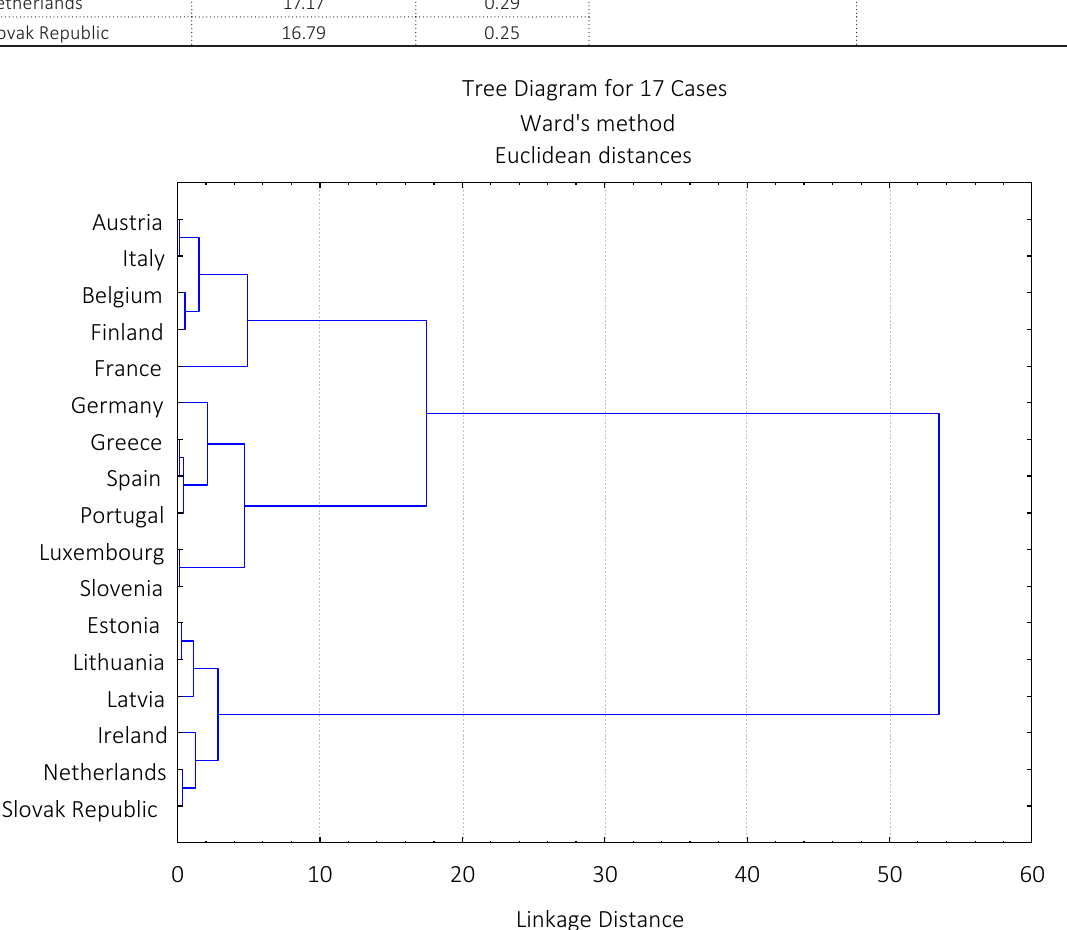
Linkage Figure 2. Country dendrogram based on social spending indicators and the social progress index